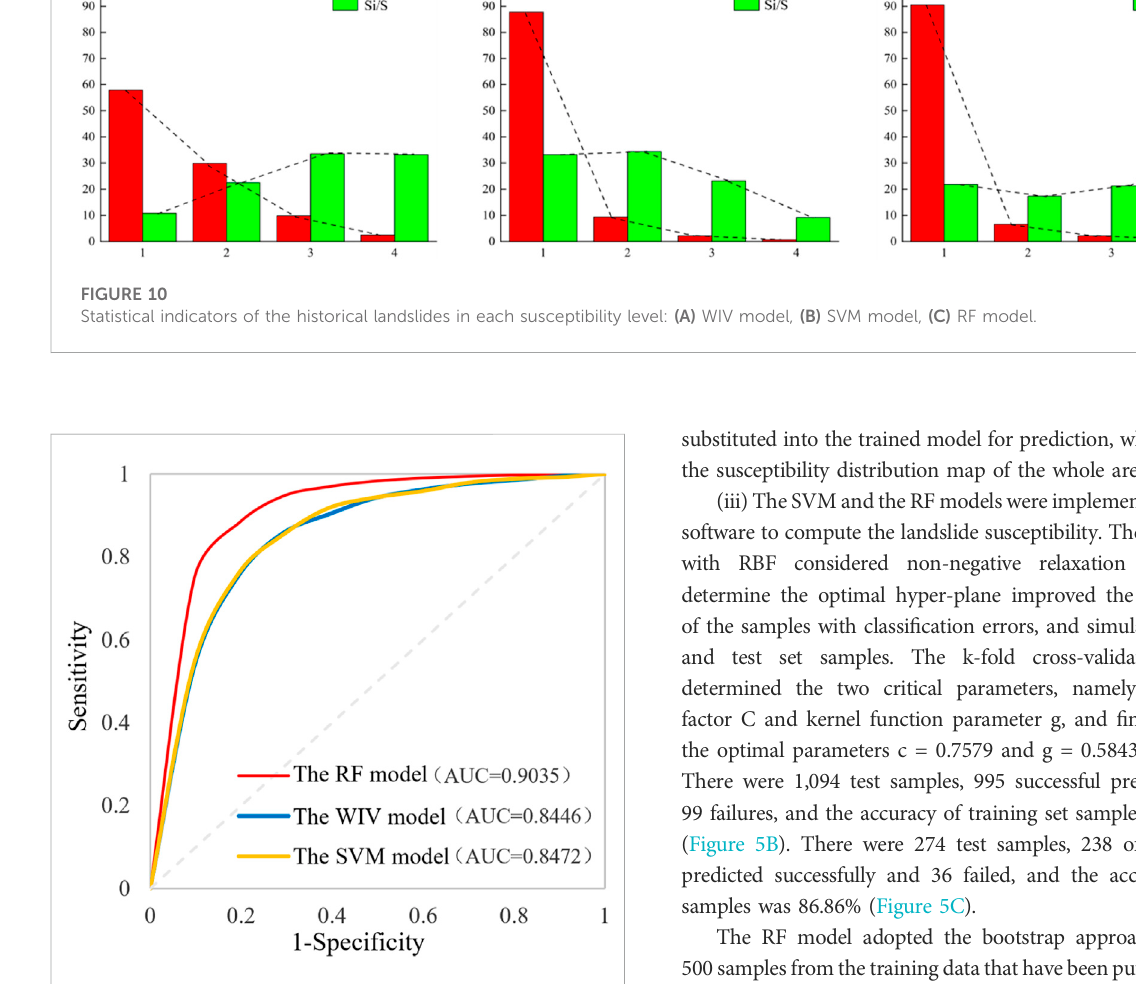
FIGURE 11 The ROC curves of the three data-driven models in landslide susceptibility